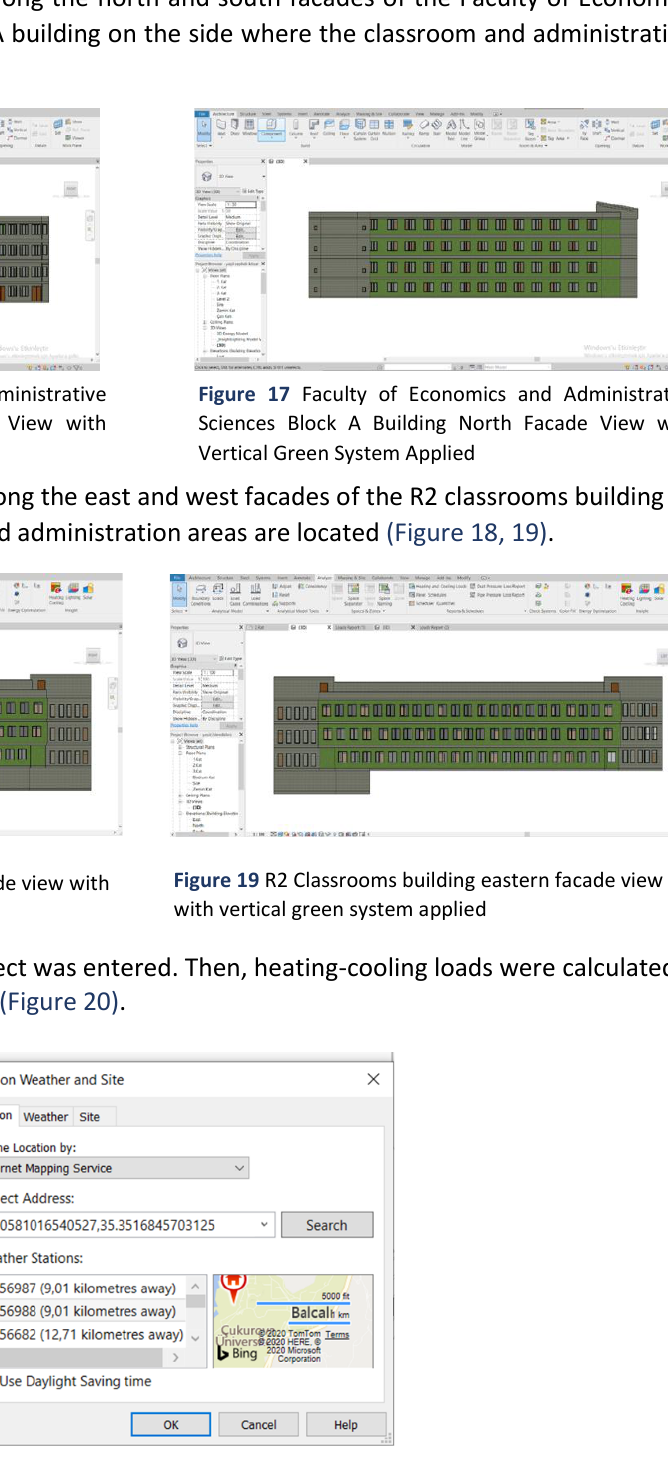
Figure 20 Defining location information in Revit program